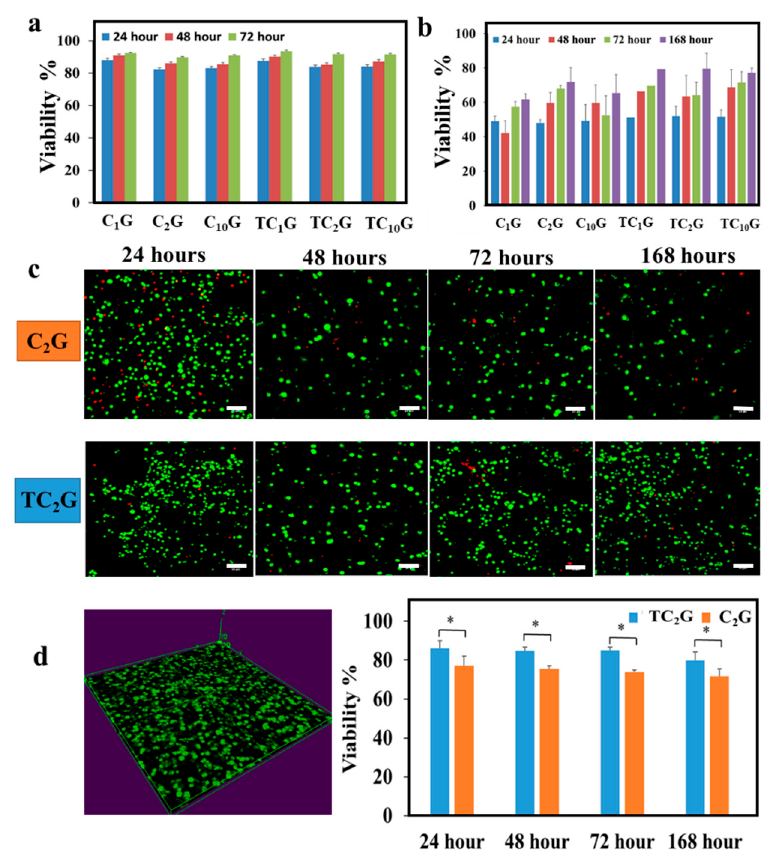
Figure 6. Effect of the different hydrogels on viability of osteoblasts seeded on these surfaces using the direct contact method up to 168 h ( a ) and the indirect contact method up to 72 h ( b ). ( c ): Representative confocal laser microscopic images stained using the live/dead assay for osteoblasts encapsulated in C 2 G and TC 2 G for 24, 48, 72 and 168 h (Scale bar is 50 µ m). The green colour indicated viable cells and the red colour indicated non-viable cells. ( d ) image of hybrid hydrogels showing cells were encapsulated and evenly distributed within the hybrid hydrogels. Viability percentages of encapsulated osteoblasts in hydrogels at 24, 48, 72 and 168 h. The viability of cells was ≥ 70% at 168 h. Data are expressed as mean ± SD (n = 3). * denotes significant difference in viability percentage ( p < 0.05) identified between the two hydrogels.